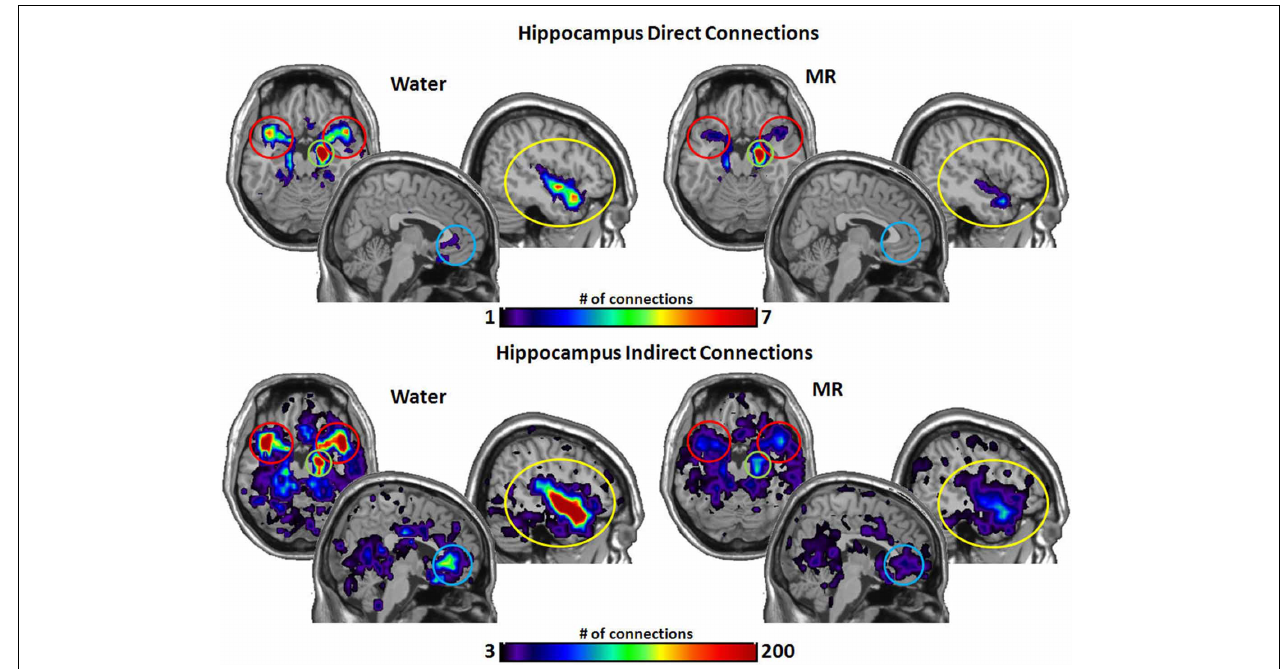
FIGURE 7 | The brain images on the top demonstrate the total number of direct connections from the right hippocampus averaged across participants. The top images demonstrate the right hippocampus has a greater number of direct connections with the insula and to the STP in the water condition than in the MR condition. The brain images